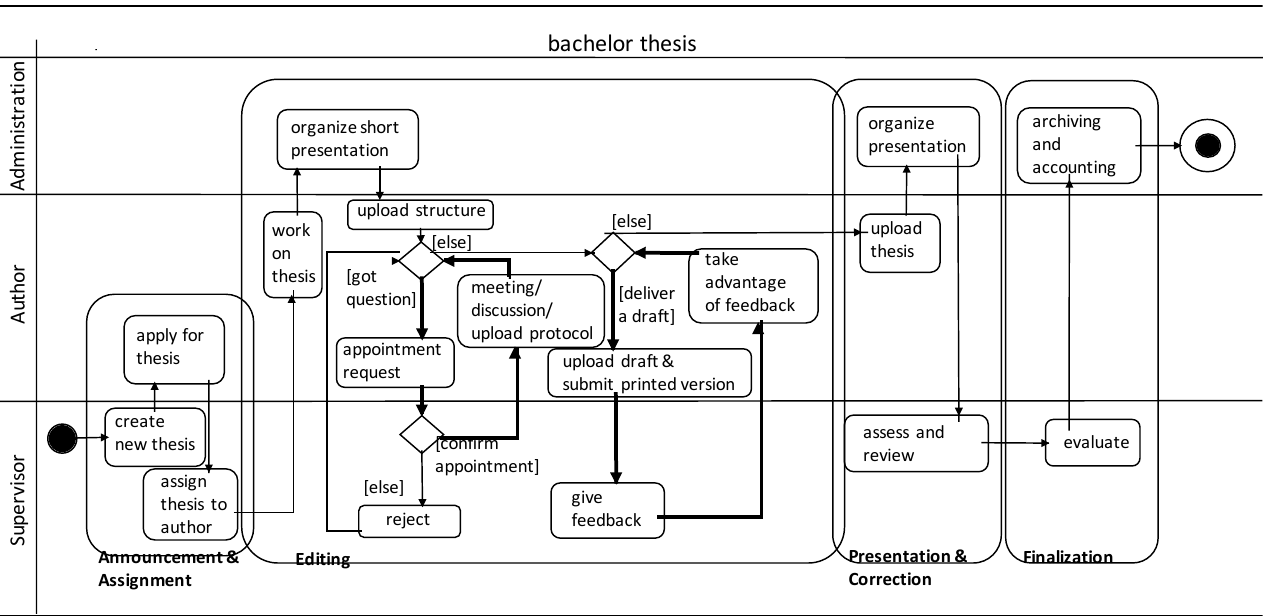
limitations to extend ThesesDB with this